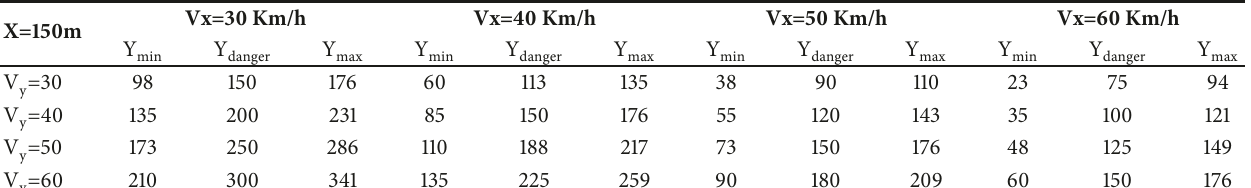
Table 6: Starting position of minor road vehicle (Y).